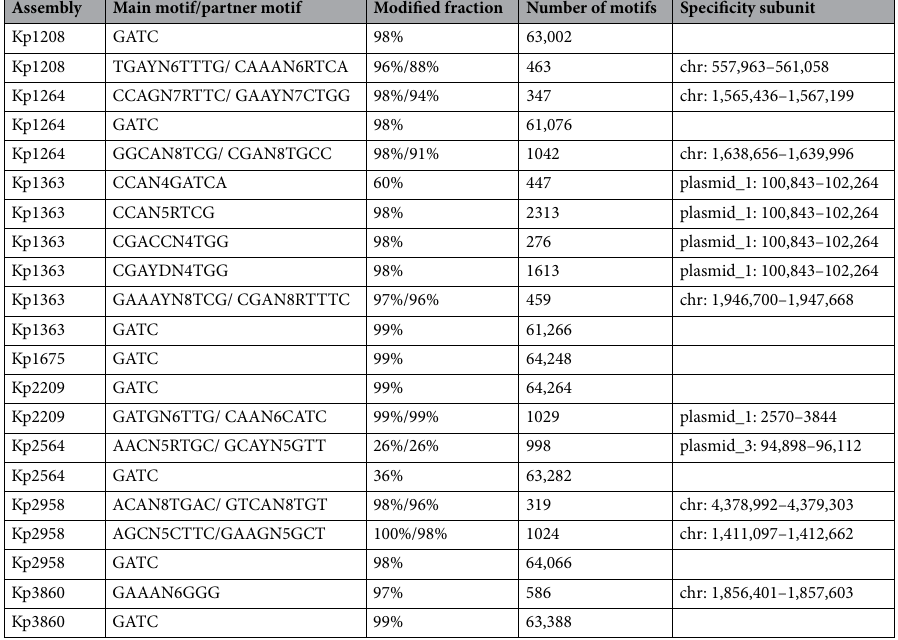
Table 2. List of high-quality m6A motifs. Only the GATC motif was present in multiple isolates, consistent with widespread presence of DNA adenine methylase among Gammaproteobacteria. Kp2564 has low methylation rates due to low sequencing